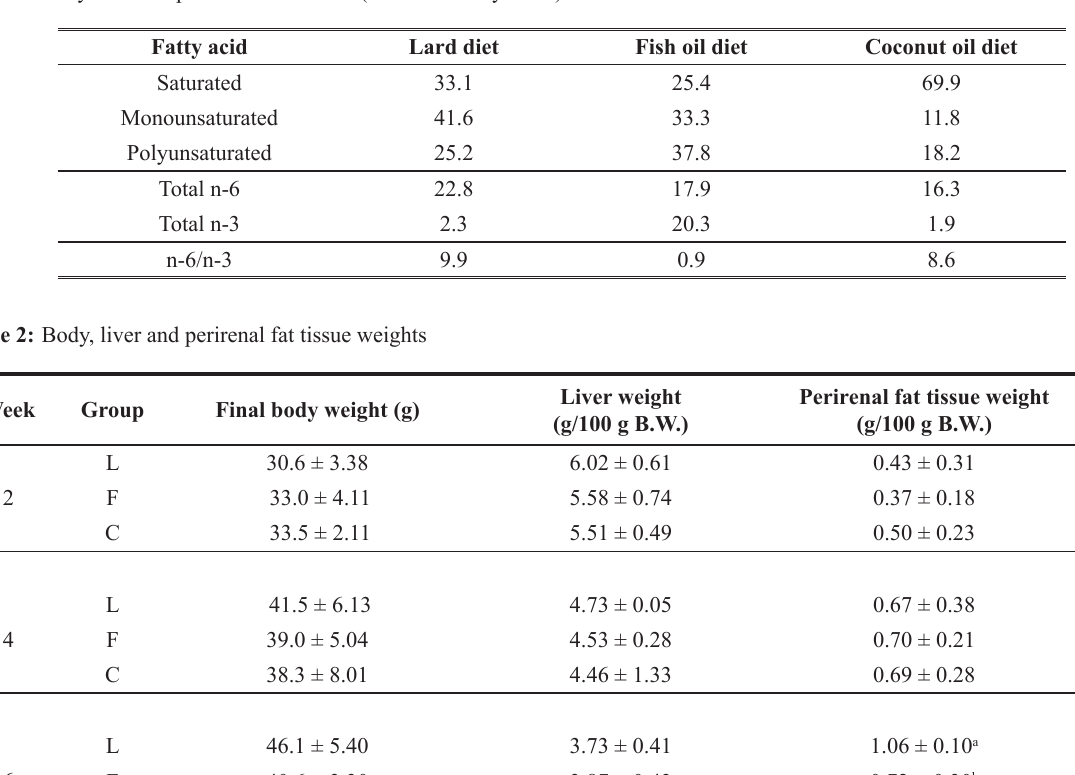
Table 1: Fatty acid composition of the diets (% of total fatty acids) Fatty acid Lard diet Fish oil diet